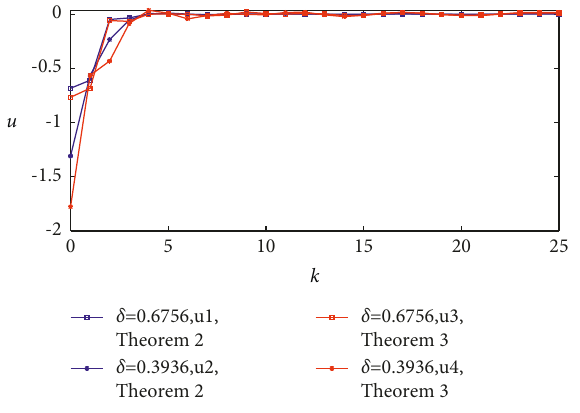
Figure 20: Control input